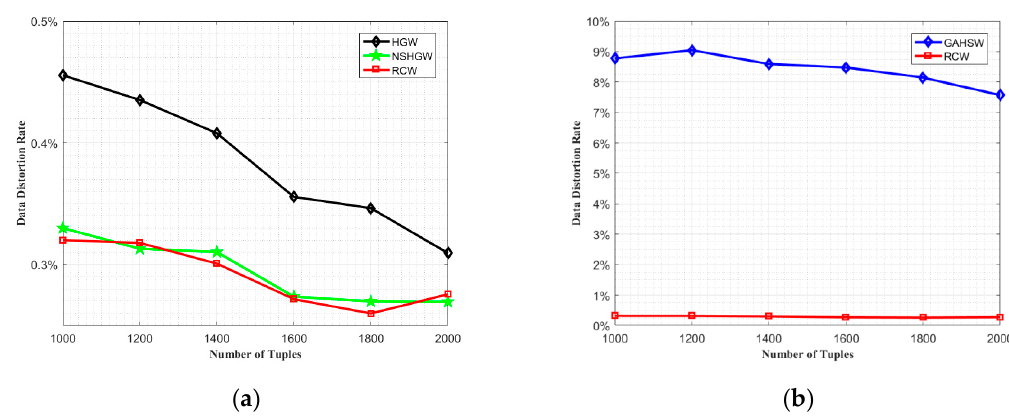
Figure 3. The comparison of data distortion rates caused by 48-bit watermarks. ( a ) The Comparison of distortion rates for RCW, Histogram-Gaps based Watermarking (HGW), and Non-Redundancy Shifting Based Histogram-Gaps (NSHGW); ( b ) The Comparison of distortion rates for RCW and Genetic Algorithm and Histogram Shifting Watermarking (GAHSW).